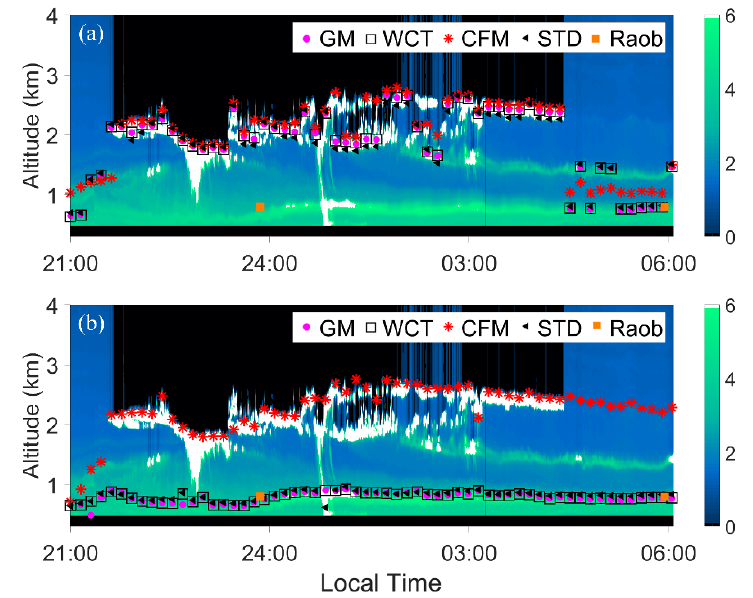
Figure 12. Same as Figure 9, except for 25–26 August 2017, 21:00–06:00 LT. Clouds are above and within the PBL presented as a white region during this